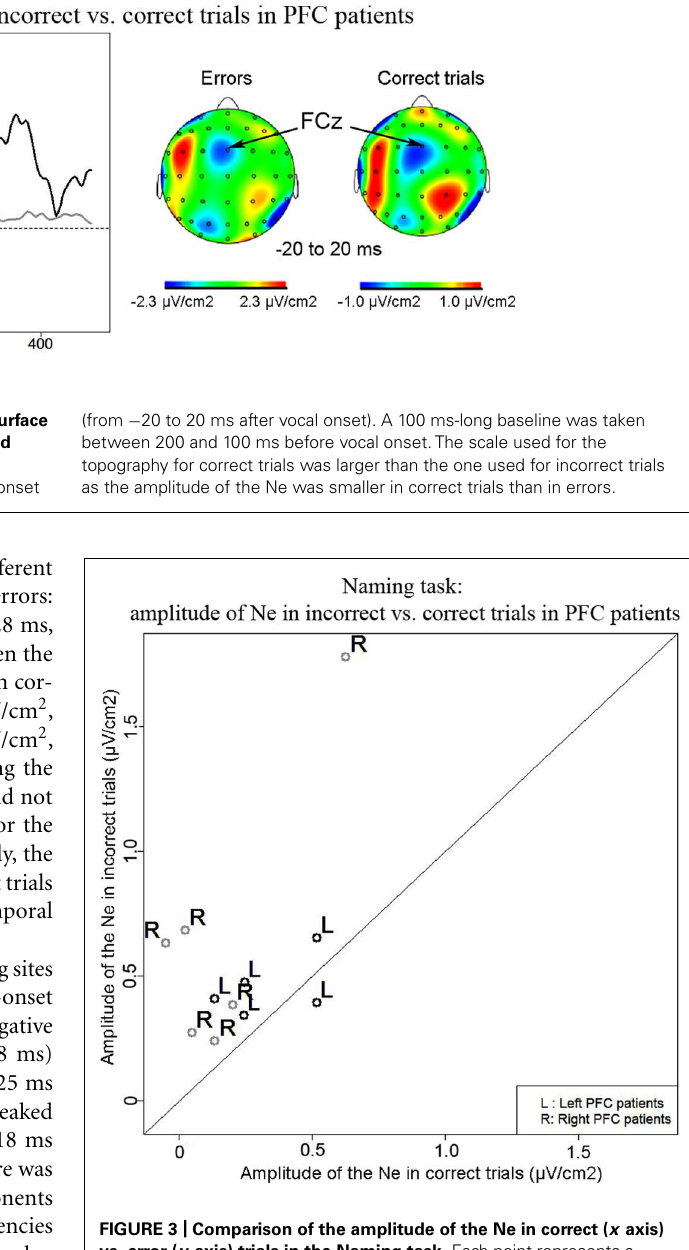
FIGURE 3 | Comparison of the amplitude of the Ne in correct ( x axis) vs. error ( y axis) trials in the Naming task. Each point represents a patient, points for left PFC patients are black and indicated by the letter “L” and points for right PFC patients are gray and are indicated by the letter “R.”